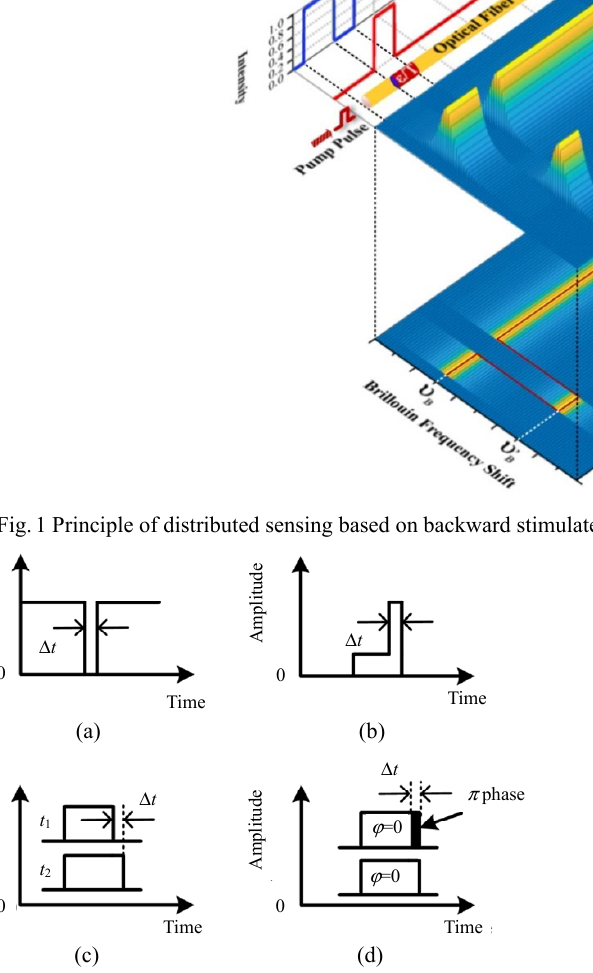
Fig. 2 Four main techniques and the corresponding pulse modulation methods: (a) dark-pulse technique, (b) PPP technique, (c) DPP te chnique, and (d) Brillouin echo technique